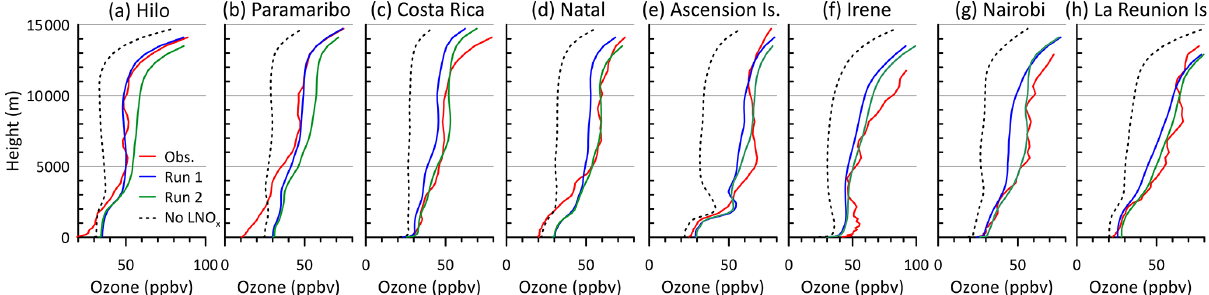
Figure 13. Profiles of annual-mean ozone constructed using the SHADOZ ozonesonde measurements at eight sites for the year 2006, and the corresponding modelled profiles obtained using the default PR92 parameterisations (Run 1) and the new lightning flash-rate parameterisations from this study (Run 2). The modelled profiles without LNO x are also shown as a reference.